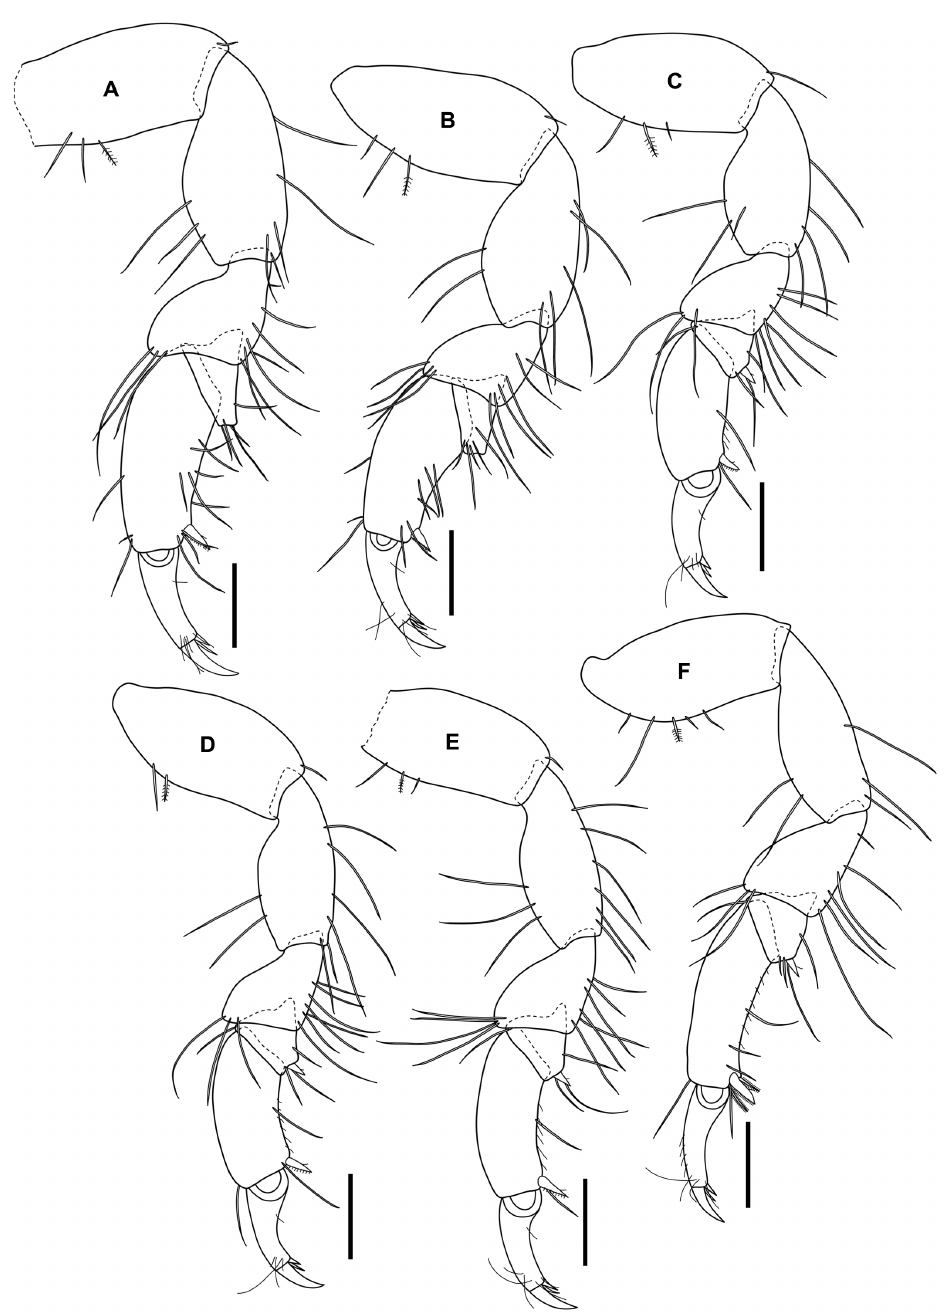
Figure 8. Tinggianthuraalba sp. n., allotype, male, (UKMMZ-1480). All scales represent 0.1 mm. (A) pereopod 2, (B) pereopod 3, (C) pereopod 4, (D) pereopod 5, (E) pereopod 6, (F) pereopod 7. border subdistally, subdistal region with 4 pairs of long setae dorsally (Figure 6E).